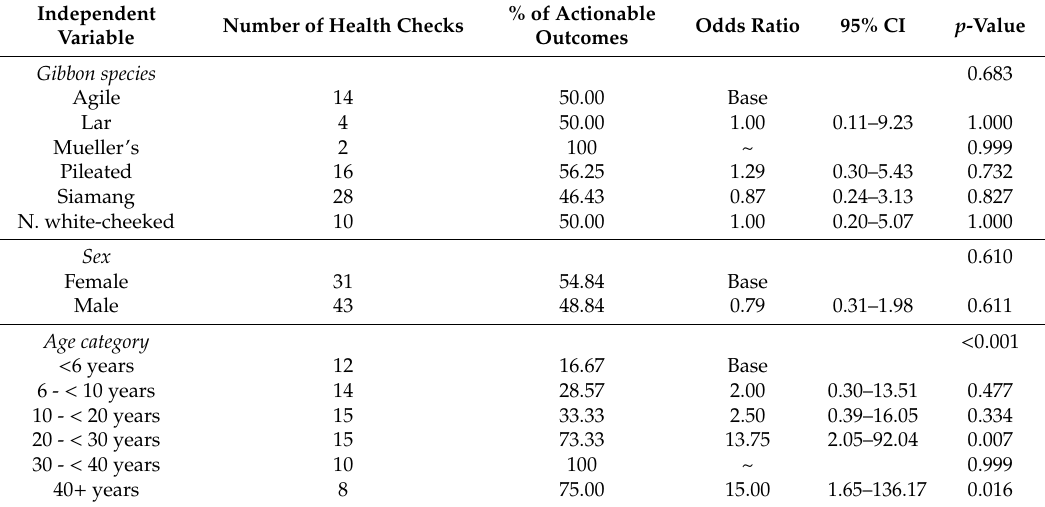
Table A2. Univariable logistic regression results for variables potentially associated with actionable outcomes during elective health checks carried out on gibbons between 2011 and